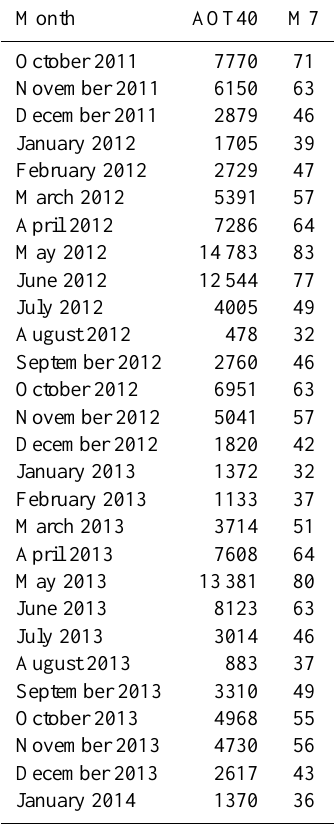
Table 3. Monthly values of M7 and increments in AOT40 for